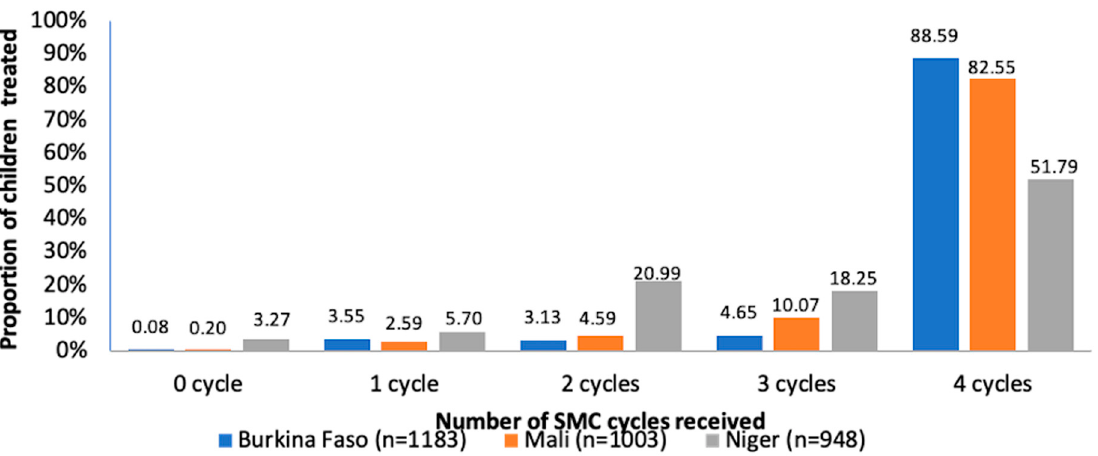
Figure 1. SMC coverage in Burkina Faso, Mali and Niger.